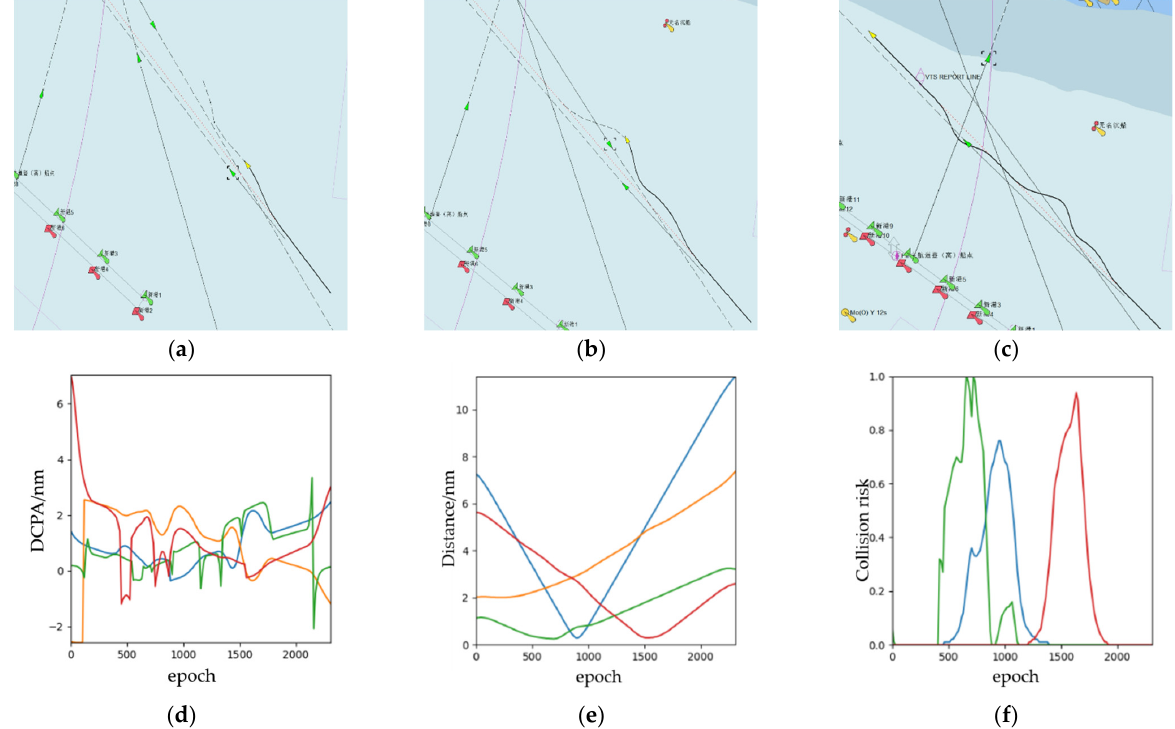
Figure 11. The experimental results (multi-ship encounter into open water): ( a ) the start time during the collision avoidance process; ( b ) the middle time during the collision avoidance process; ( c ) the end time during the collision avoidance process; ( d ) DCPA; ( e ) distance; ( f ) collision risk (Some subgraphs include some Chinese name and number information of navigation lights in channel, which is inherent in the system of ECDIS and has no influence on the conclusion of this